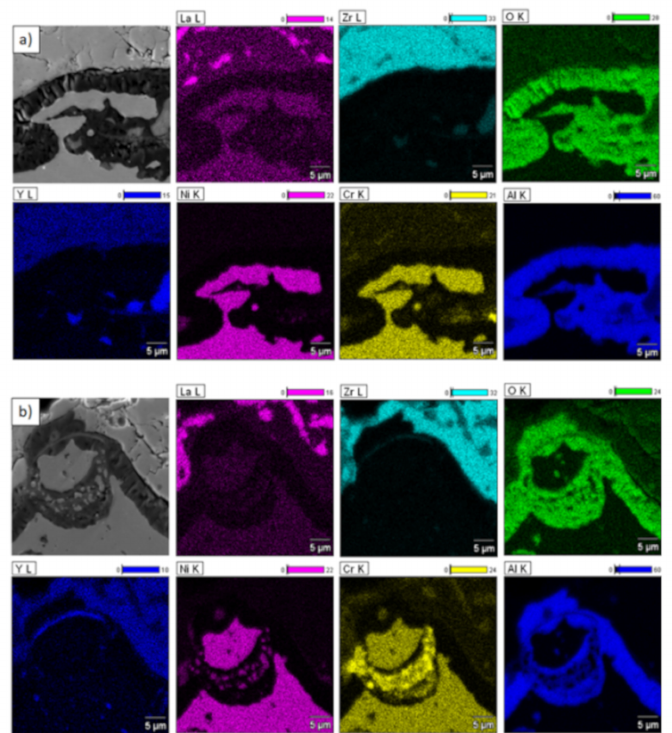
Figure 18. Element distribution in TGO zone after 500 h of oxidation at a temperature of 1100 ◦ C—composite 50% La 2 Zr 2 O 7 + 50% 8YSZ TBC (SEM): ( a ) zone of the bond-coat bottom and ( b ) zone of the bond-coat top.